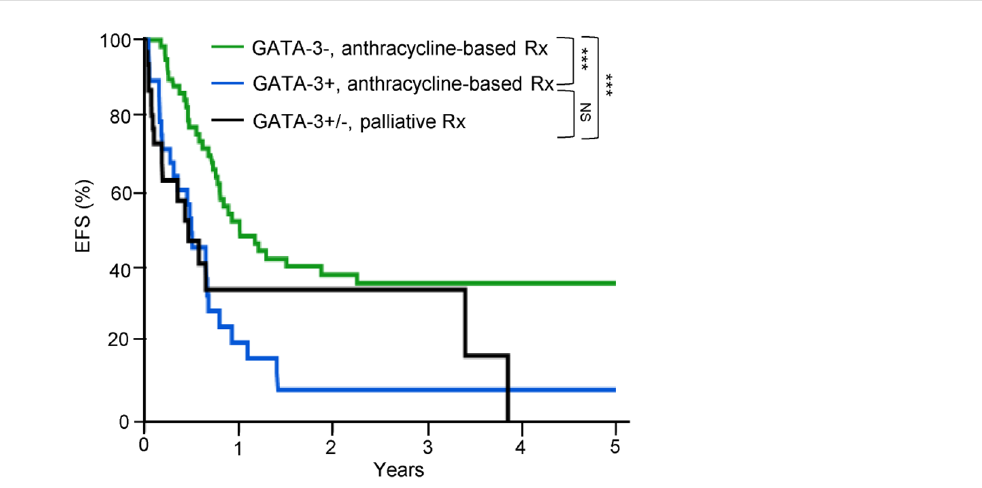
FIGURE 1 GATA-3 expression is associated with dismal outcomes in PTCL, NOS. GATA-3 expression was determined by immunohistochemistry and patients were strati fi ed by treatment. Among GATA-3 positive patients (n=28) that received fi rst-line anthracycline-based chemotherapy, 86% received CHOP or CHOEP. Among GATA-3 negative patients (n=61), 87% were treated with CHOP/CHOEP. Consistent with prior studies, GATA-3 expression was associated with inferior event-free survival (EFS). Importantly, no signi fi cant improvement in EFS was observed for GATA-3+ patients treated with CHOP/ CHOEP in comparison to PTCL, NOS patients (n=33) who received palliative or best supportive care alone (72% hospice care with or without corticosteroids), highlighting the futility of current therapies in this subset. [Data reprinted with permission from